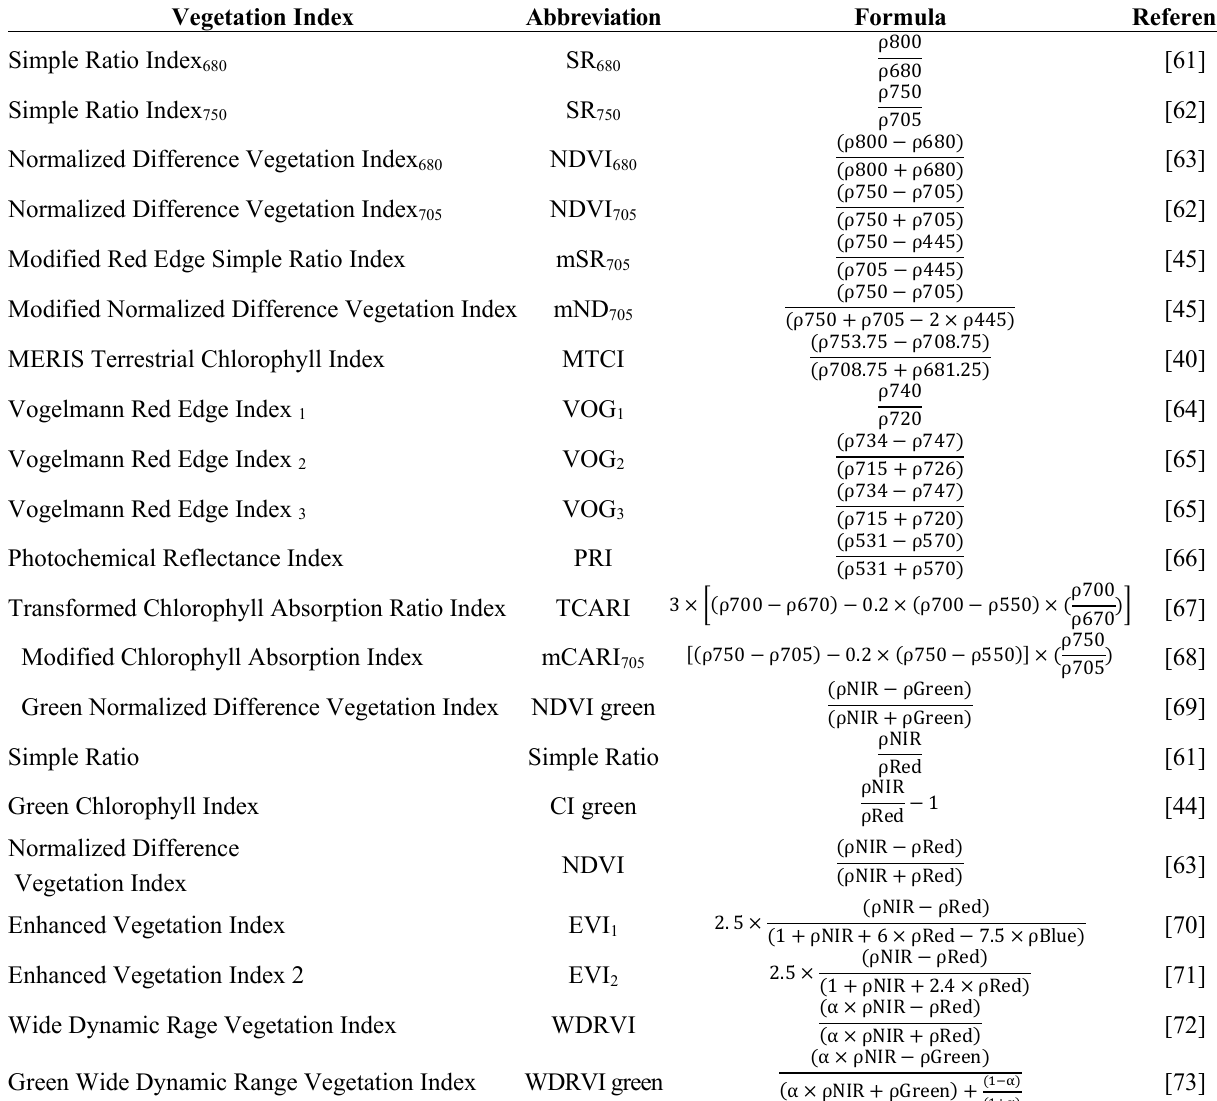
Table 1. Hyperspectral and broad band indices used in this